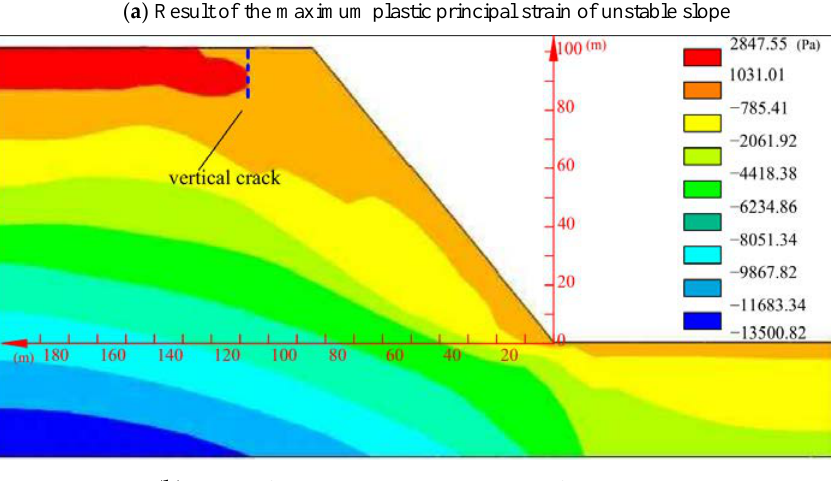
Figure 17. Results of slope stability calculated by finite element method from ANSYS.